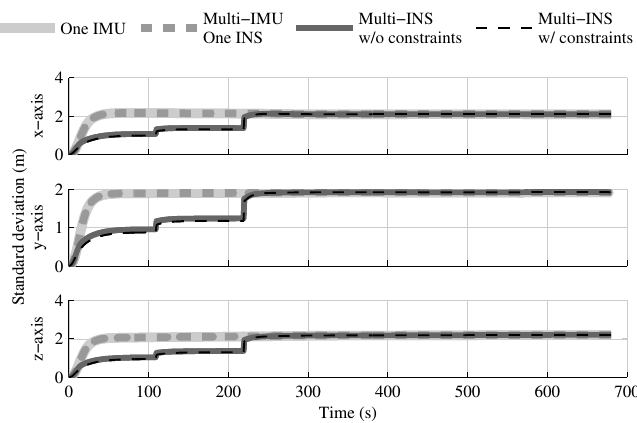
Figure 20. The velocity estimation error standard deviation obtained with the navigation solutions, when the attitude reference sensor and GPS receiver are present.